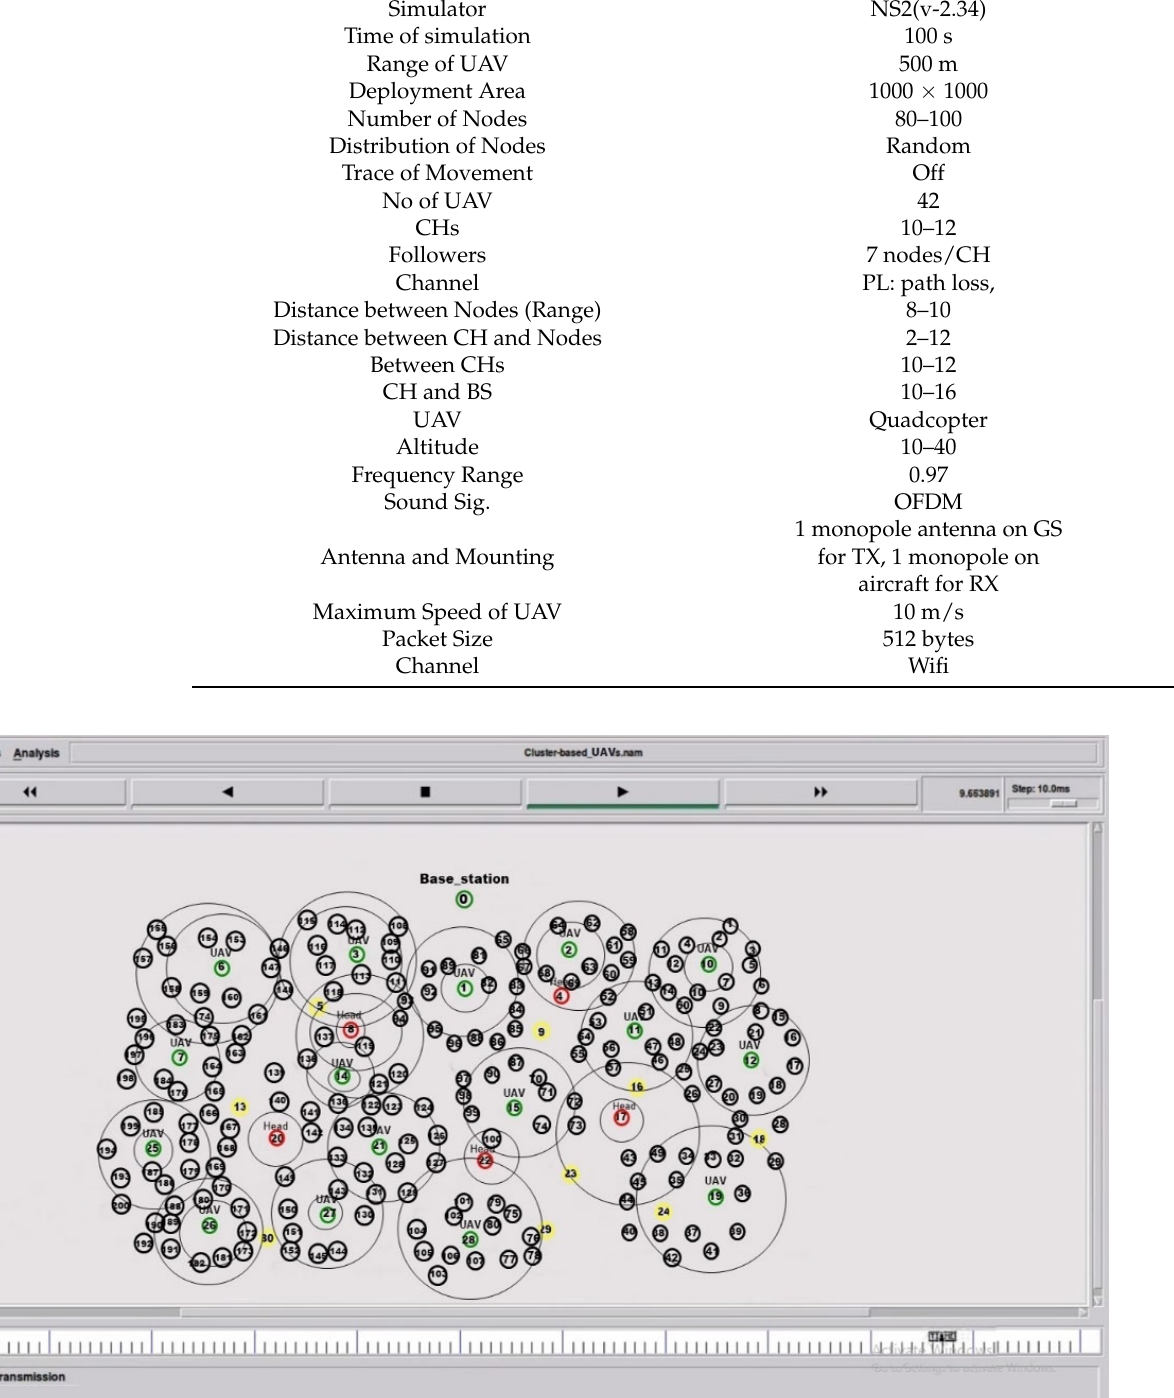
Figure 9. Final result with obstacle placement.